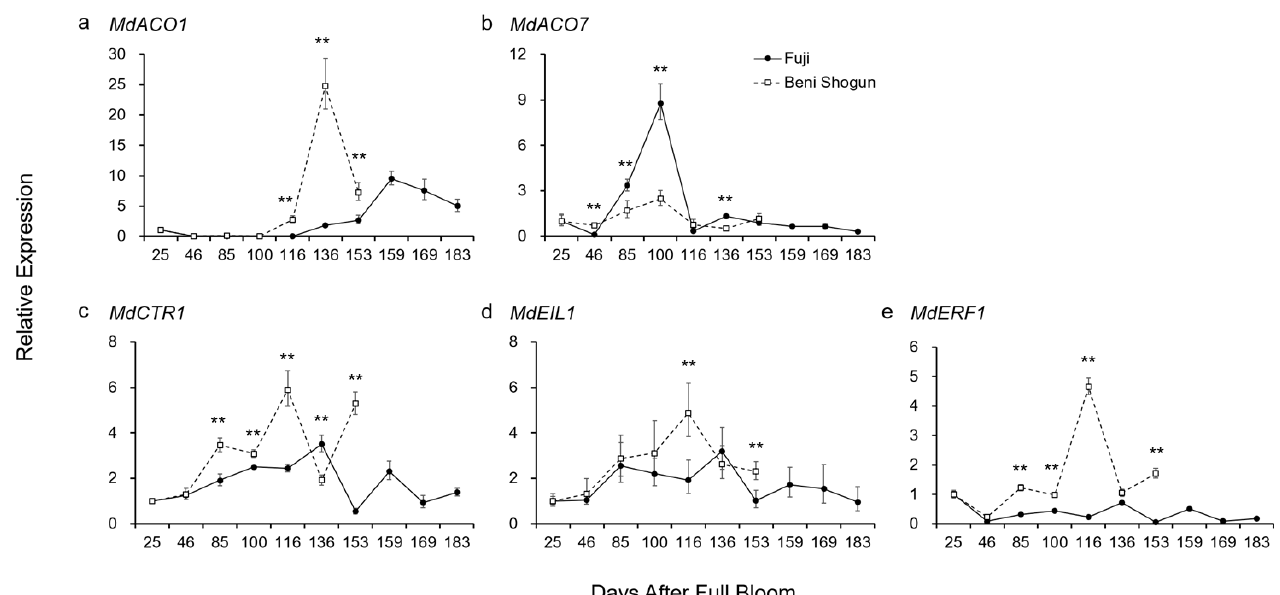
Figure 3. Relative gene expression patterns related to ethylene in ‘Beni Shogun’ and ‘Fuji’ during fruit development. Genes are grouped as ethylene synthesis ( a , b ) ( MdACO1 and MdACO7 ) and signal transduction ( c – e ) ( MdCTR1 , MdEIL1 , and MdERF1 ) genes. All genes were analyzed by using qRT-PCR and normalized relative to the expression reference gene, ACTIN . Relative expression levels were normalized to 25 DAFB values. Error bars indicate the ±SE ( n = 3). Double stars (**) indicate significance at p < 0.01.